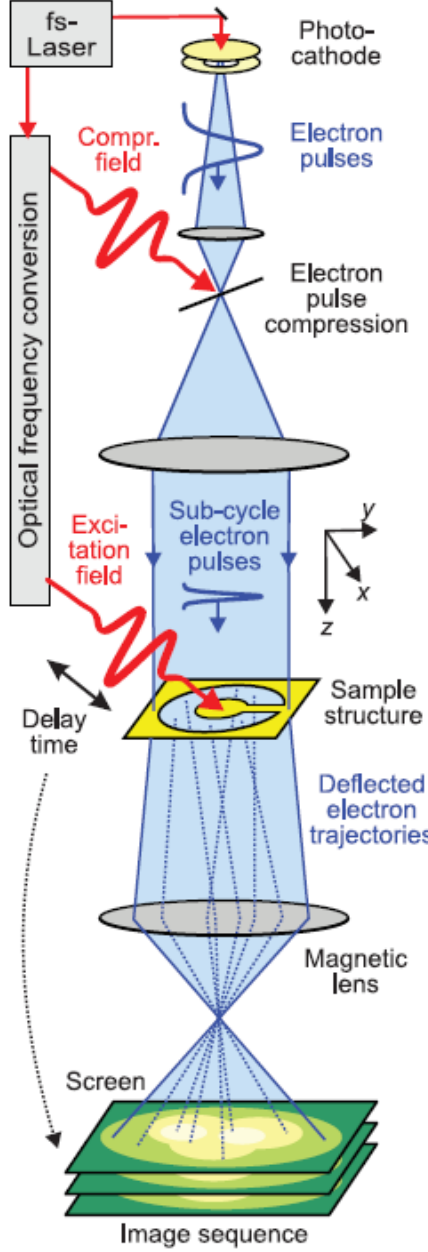
Figure 3. Schematic diagram of electron microscopy of electromagnetic waves [43]. Some part of the femtosecond laser radiation irradiated the photocathode to generate a pulsed electron beam, while the rest formed single-cycle terahertz pulses. The terahertz radiation, in turn, compressed electron pulses, and, also, induced electromagnetic resonance in the sample. As a result, the pulsed electron beam of femtosecond duration collimated by magnetic lenses passed through a metamagnetic resonator excited by single-cycle electromagnetic bursts. Because the probe pulses were shorter than the half-period of the electromagnetic field, the Lorentz forces “frozen” in time distorted the image of the excited sample, thereby providing a unique opportunity to visualize the electromagnetic field inside the substance with detection of its phase, amplitude, and polarization. Figure adapted from work in [43] with permission from Science AAAS.